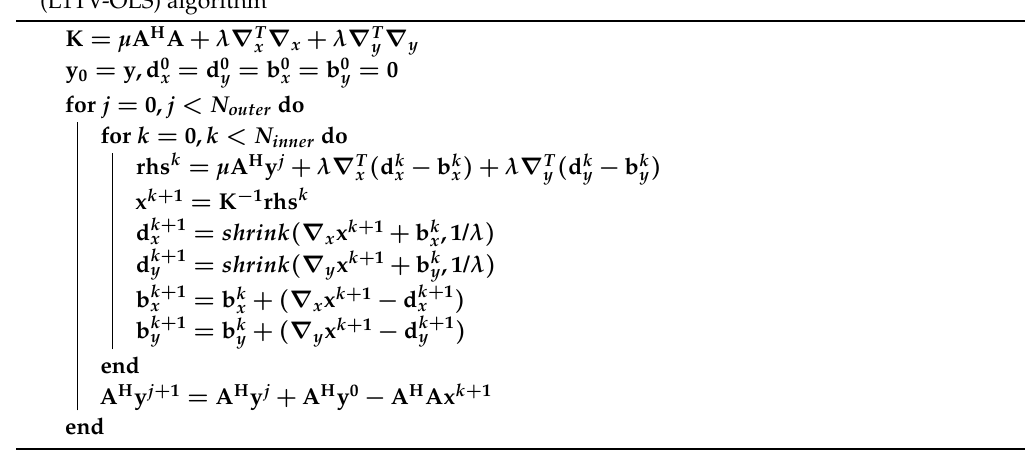
Algorithm 1: The pseudocode for the (cid:96) 1 total variation-regularized ordinary least square (L1TV-OLS) algorithm